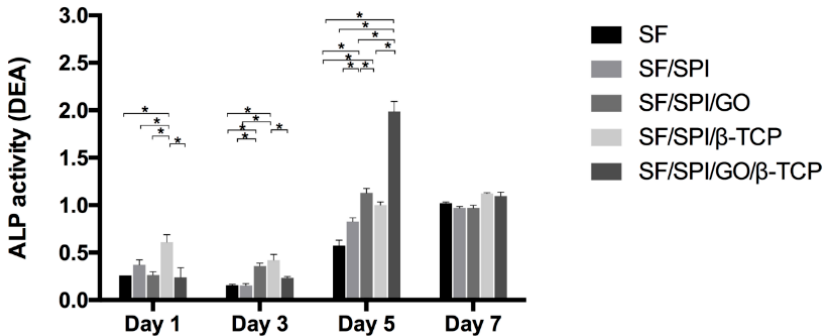
Figure 12. ALP activities of BMSCs on the SF/SPI-based composite scaffolds on day 1, 3, 5 and 7. Statistical significance relative to each group: * p < 0.05.